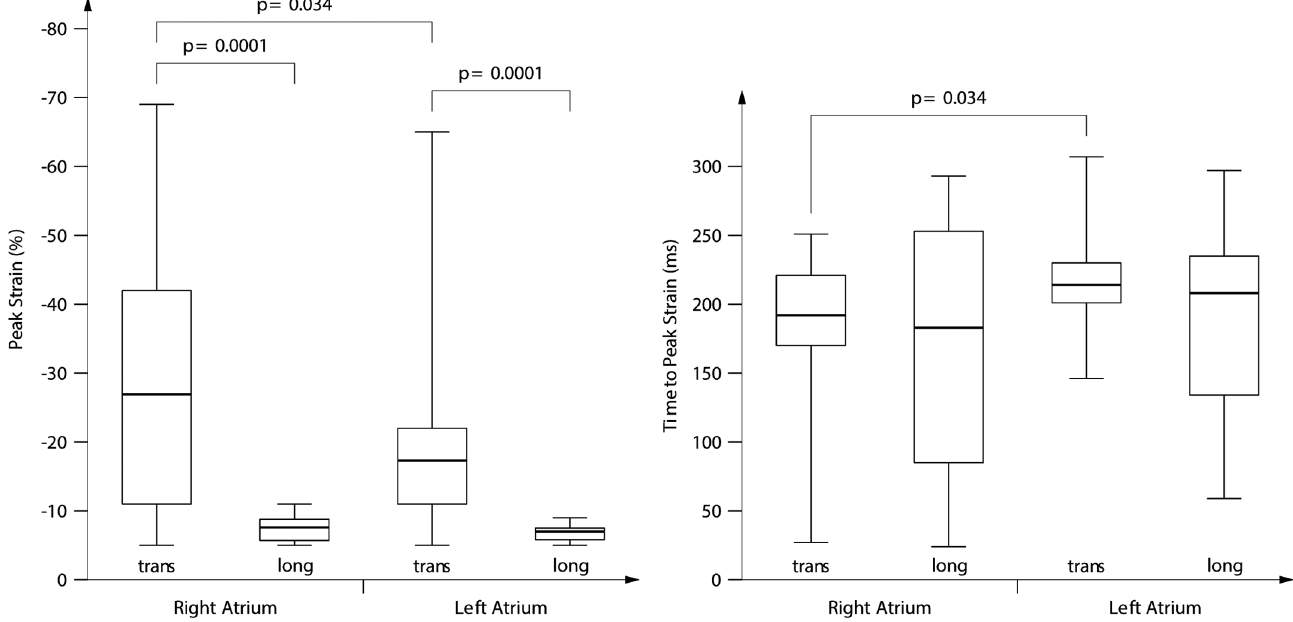
Fig 3. Absolute peak strain (left) and time to peak strain (TTPS) (right) for right (RA) ( ROI 1 ) or left atrium (LA) ( ROI 2 ) in the transverse (trans) or longitudinal (long) four chamber view. Note that for the sake of visual comparison, numbers for strain are depicted as values so that numbers for both longitudinal and radial strain are “positive”; normally, radial strain (transverse four chamber view) would be negative. The boxplots indicate the median (interquartile range), the whiskers reach from minimum to maximum. The p-value indicates the statistically significant difference between